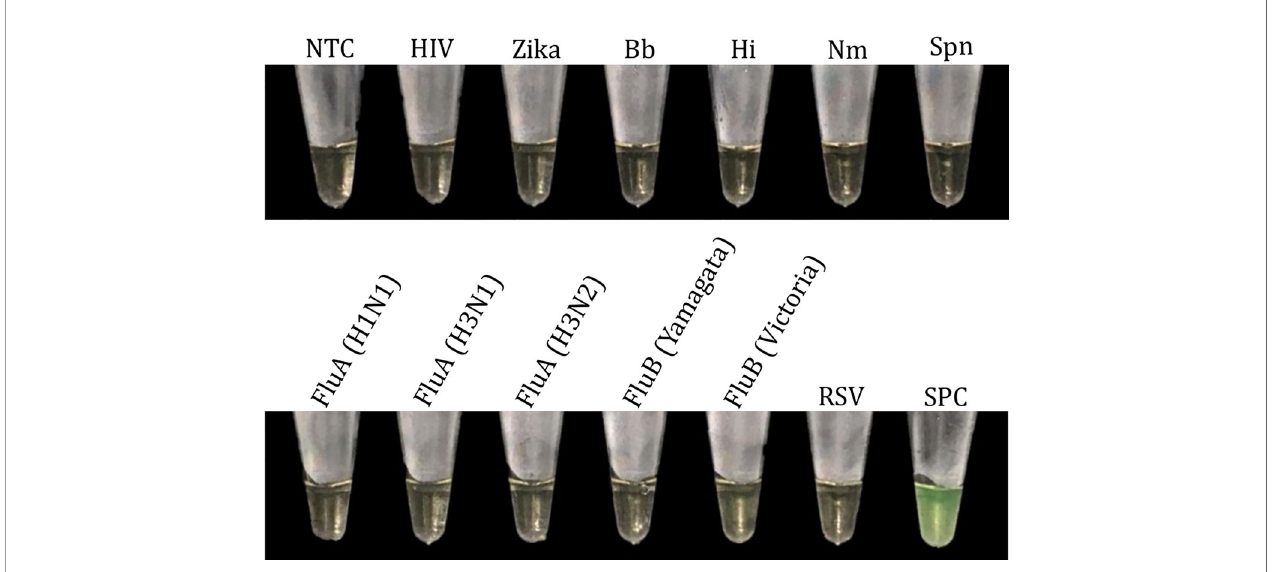
FIGURE 11 | Analytical speci fi city of the multiplex RT-LAMP assay. HIV, human immunode fi ciency virus; Zika, Zika virus; Bb, Bordetella pertussis ; Hi, Haemophilus in fl uenzae ; Nm, Neisseria meningitidis ; Spn, Streptococcus pneumoniae ; Flu, in fl uenza virus; RSV, respiratory syncytial virus; NTC, negative non-template control; SPC, SARS-CoV-2 positive control.